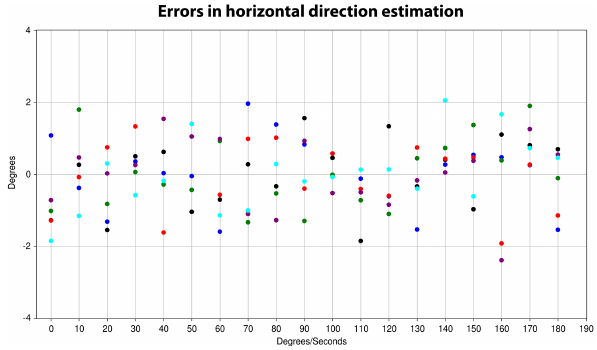
Figure 8. Differences between measured and determined angular displacements as function of the angular rate: black = gyroscope 1, blue = gyroscope 2, red = gyroscope 3, green = gyroscope 4, violet = gyroscope 5, cyan = gyroscope 6.